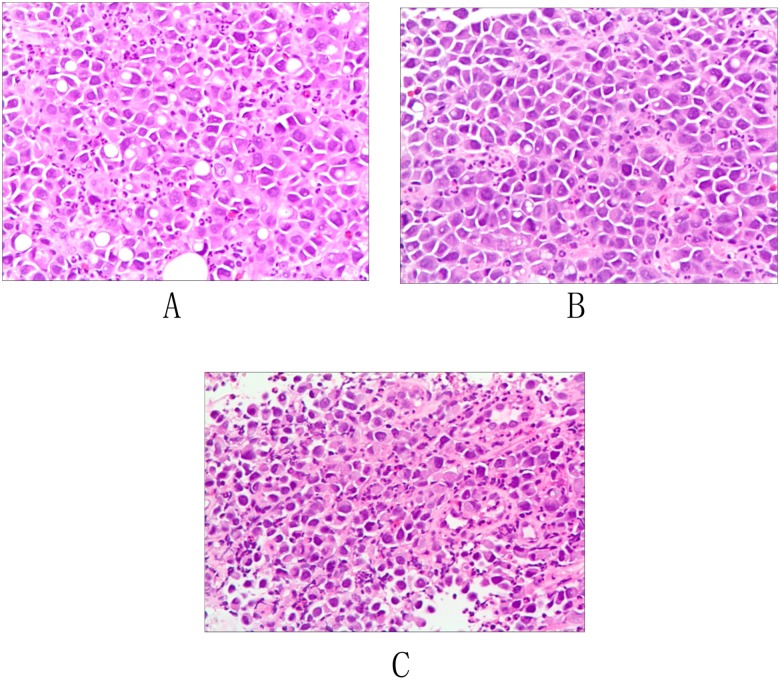
Hematoxylin and eosin—Stained section (200 magnification) of a biopsy specimen showing (A) SRC≥50% and (B) SRC<50%, and (C) poorly differentiated adenocarcinoma (reference group).